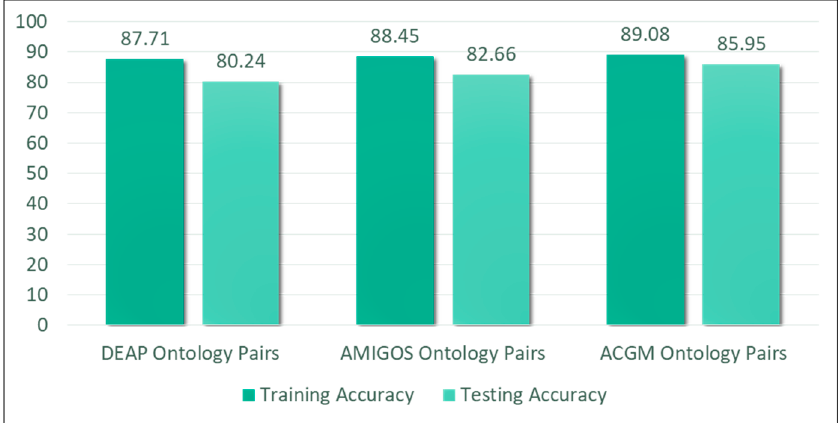
Figure 23. Semantic ontology alignment accuracy score on affective states ontologies.